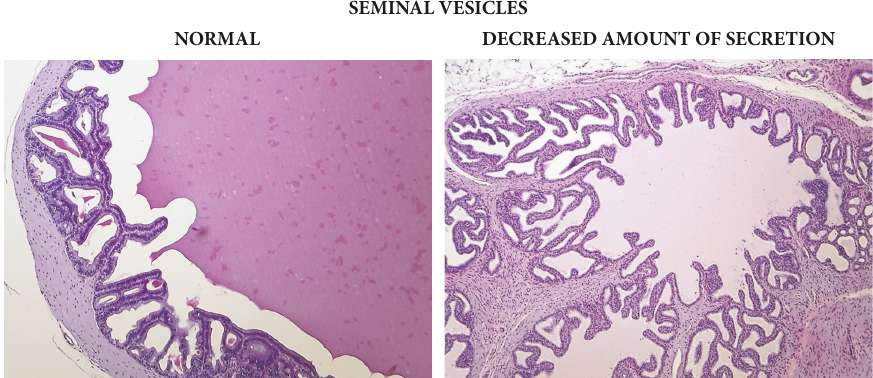
Figure 5: Seminal vesicles: comparison of normal (control) tissue to tissue from a male from the 3000/4000 mg/kg bw/day group showing decreased amount of secretion, 14-day study.